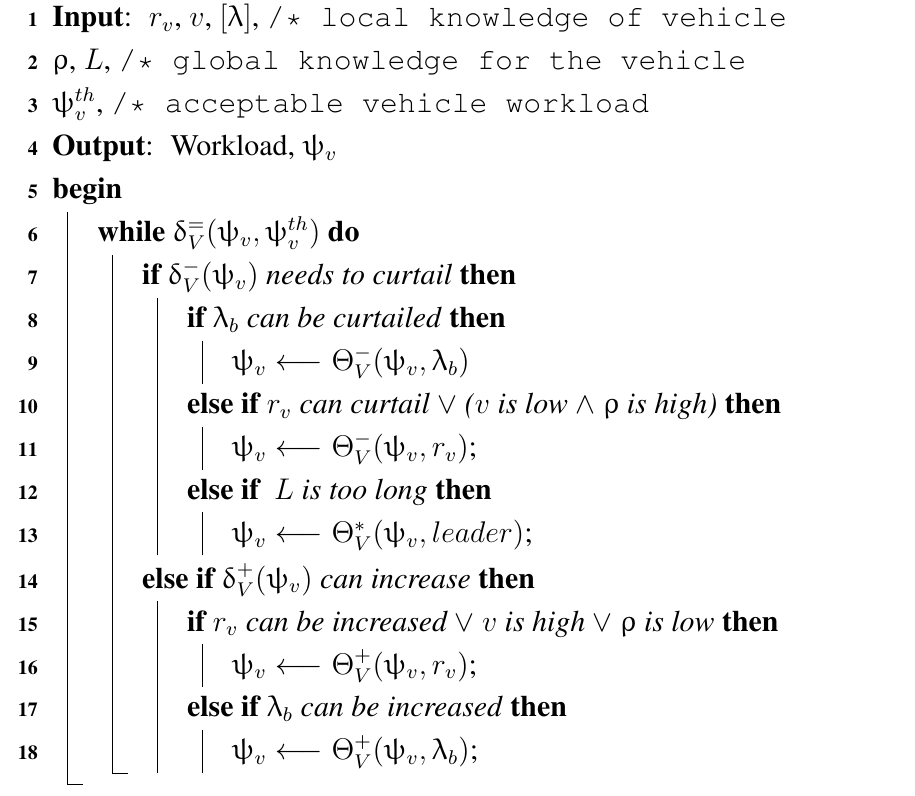
Algorithm 1: Adaptation strategy for the vehicles